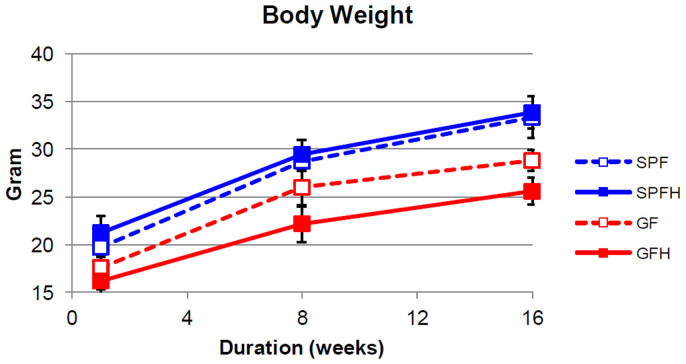
Mean body mass of mice.GF mice weighed significantly less compared to their SPF counterparts (p < 0.01). At the end of 16 weeks, neither SPF nor SPFH mice suffered from any significant weight loss (p > 0.05). However, GFH mice suffered from significant weight loss compared to GF mice (p < 0.01).